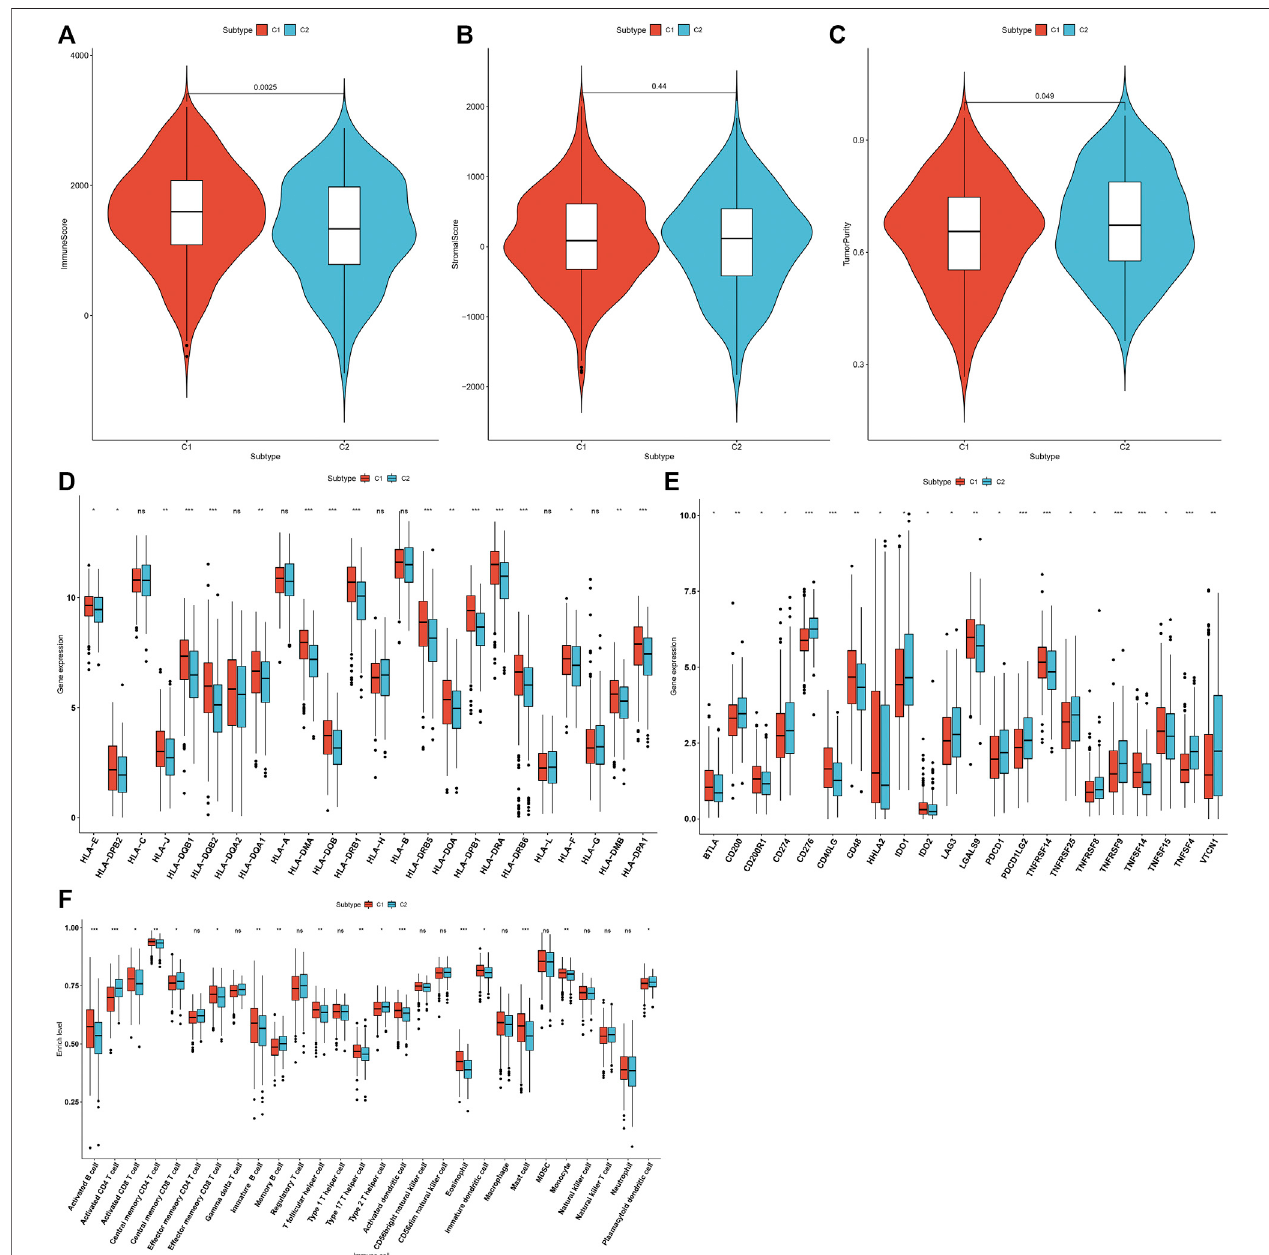
FIGURE 3 | Two m 6 A modi fi cation patterns characterized by distinct tumor immunity across 502 LUAD specimens from the TCGA cohort. (A – C) Quanti fi cation of immune score, stromal score, and tumor purity in LUAD samples from two m 6 A modi fi cation patterns through ESTIMATE algorithm. (D) Comparison of the mRNA expression of HLA genes between two m 6 A modi fi cation patterns. (E) Comparison of the mRNA expression of immune checkpoints between two m 6 A modi fi cation patterns. (F) Quanti fi cation of the in fi ltration levels of immune cells in LUAD samples from two m 6 A modi fi cation patterns via ssGSEA algorithm. Ns: not signi fi cant; * p < 0.05; ** p < 0.01; *** p <